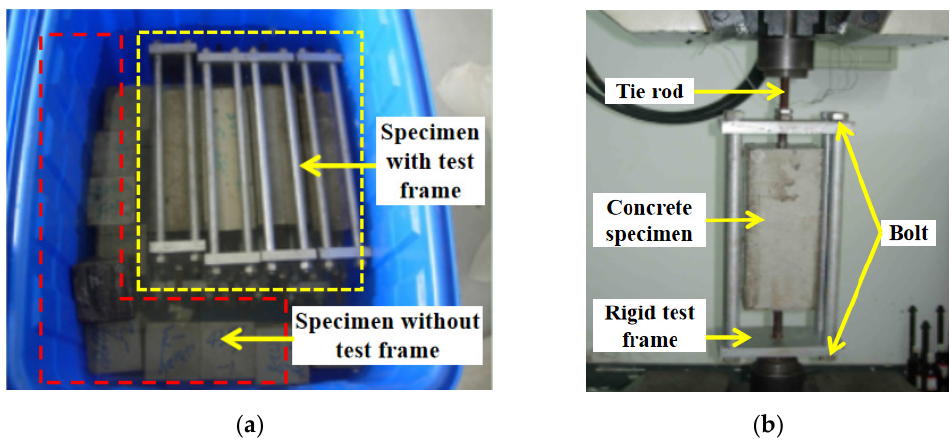
Figure 1. Specimen soaking and specimen stress rack: ( a ) specimen immersed in corrosive solution; ( b ) specimen tension device.